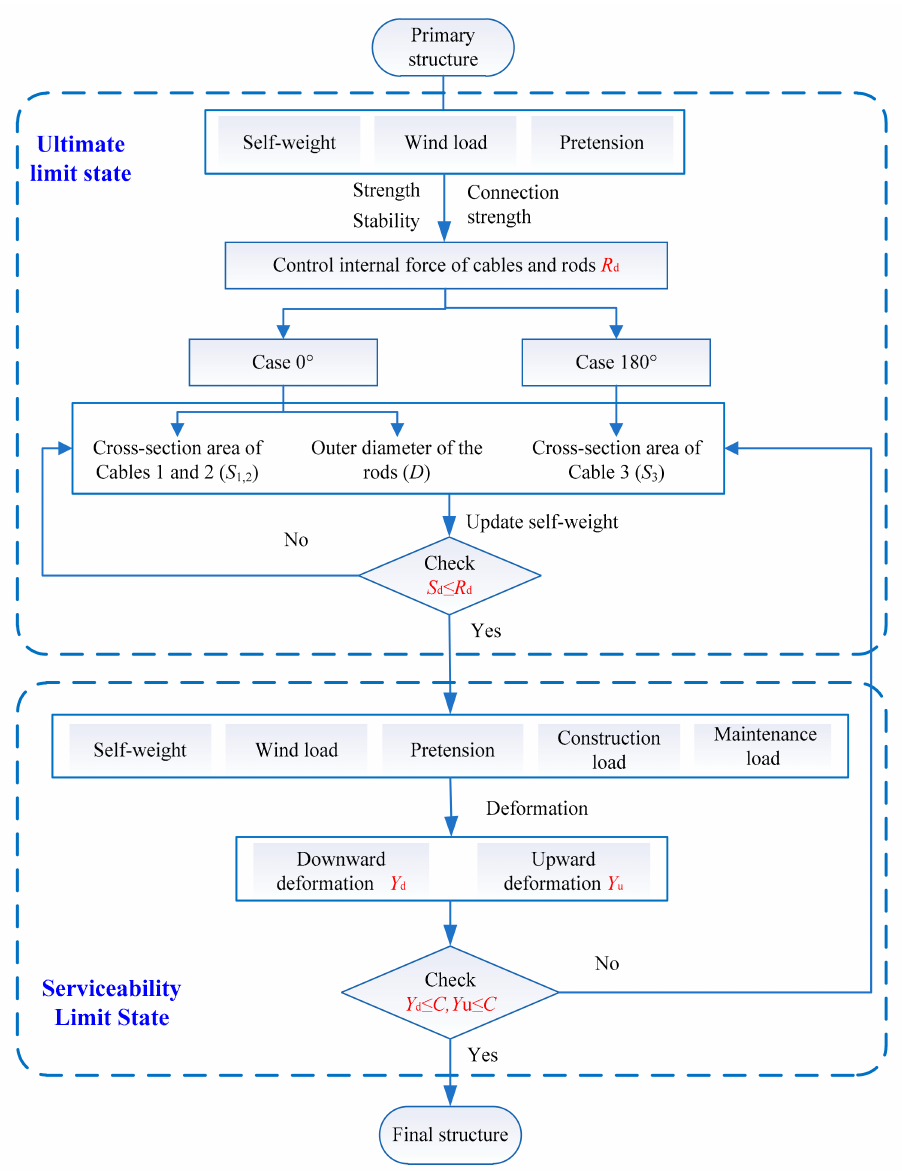
Figure 11. Sketch of the overall view of the proposed